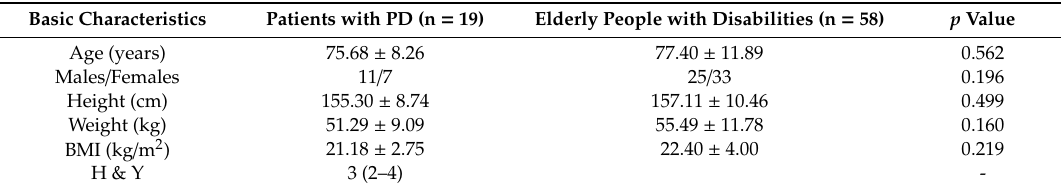
Table 1. Basic characteristics of study